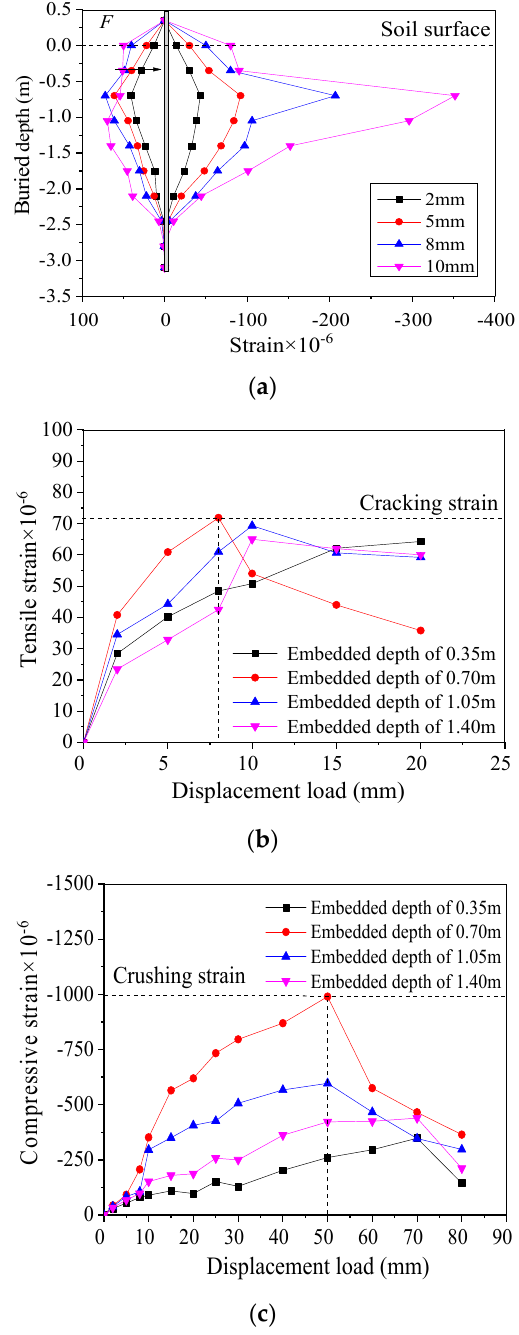
Figure 11. Strain distribution of CP-2 specimen. ( a ) Compressive and tensile strain distributions. ( b ) Tensile strain versus loading history. ( c ) Compressive strain versus loading history.